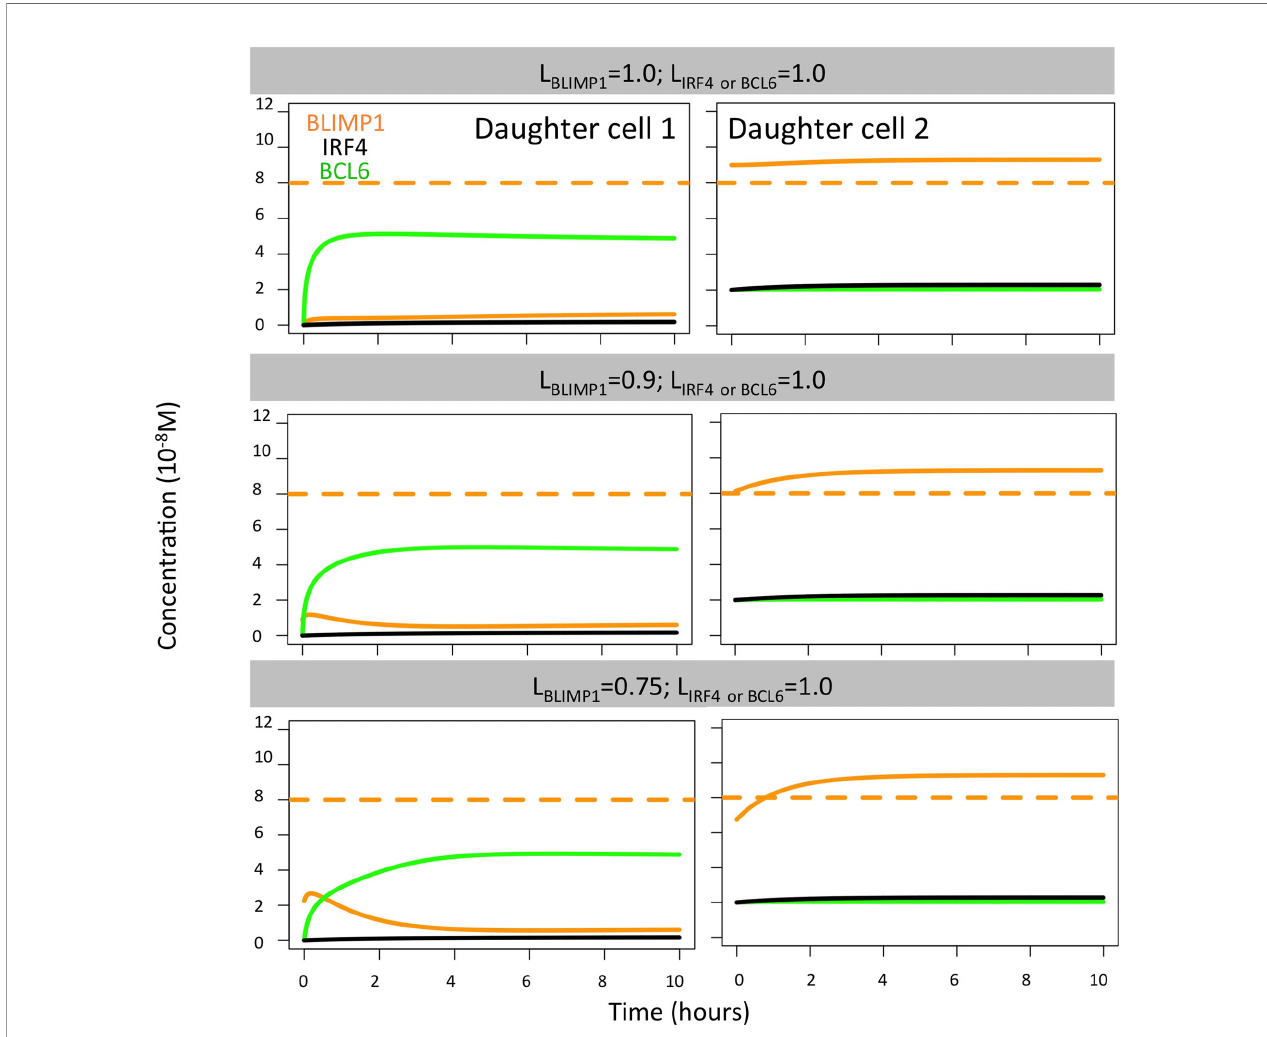
FIGURE 9 | BLIMP1 (orange), BCL6 (green), and IRF4 (black) dynamics in two theoretical daughter B cells. Their initial TF concentrations were set to simulate the asymmetric division of a parent cell (BLIMP1 = 8, BCL6 = 2, IRF4 = 2) with all different combinations of BLIMP1 levels (L BLIMP1 = 1.0, L BLIMP1 = 0.9, and L BLIMP1 = 0.75, as shown in Table 2 ). Levels of IRF4 and BCL6 were fi xed (L IRF4 = L BCL6 =